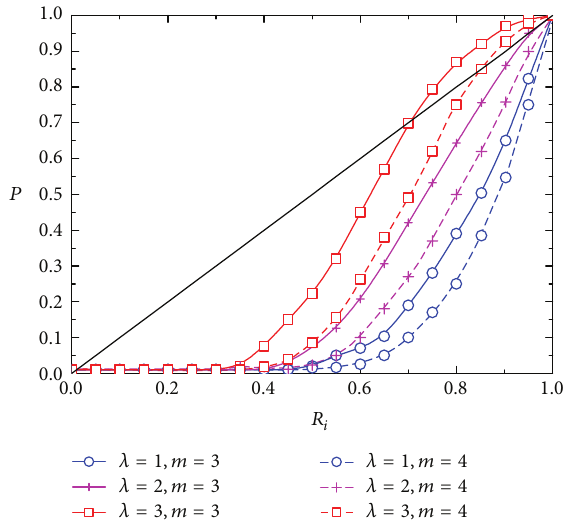
Figure 3: Relationship between the hierarchical radius and the number of channels and the throughput